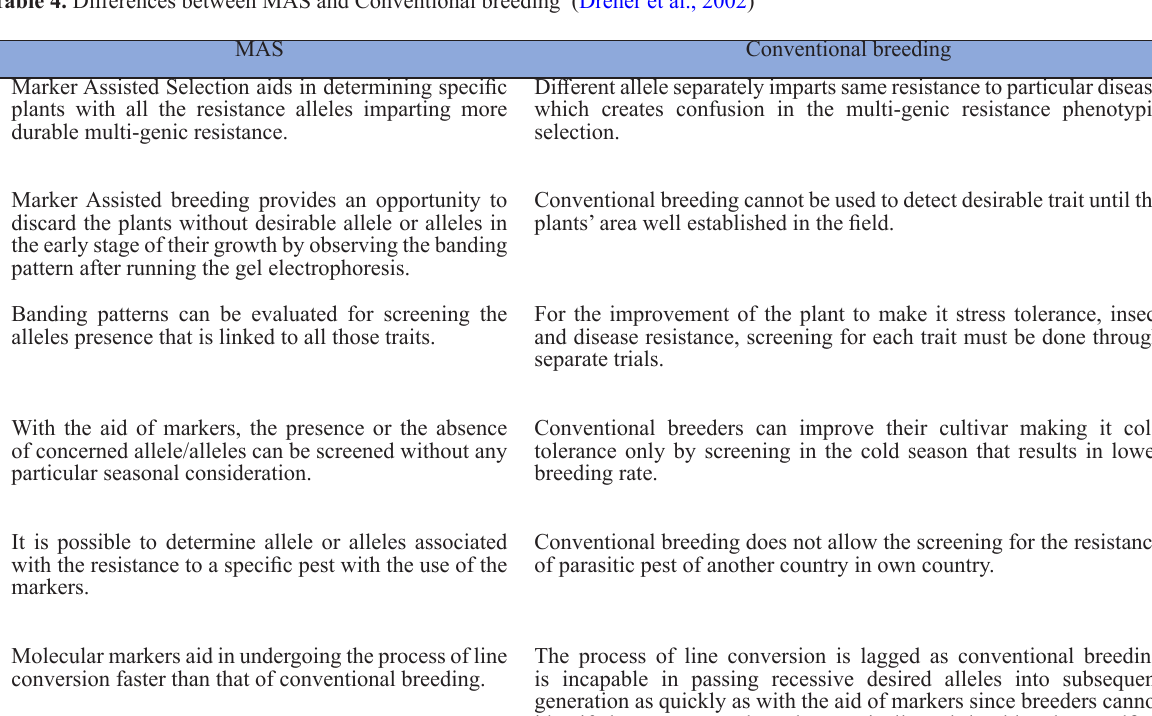
Figure 3: Comparison between conventional backcrossing and background selection during marker assisted backcrossing (Rani et al., Table 4. Differences between MAS and Conventional breeding ( Dreher et al., 2002)